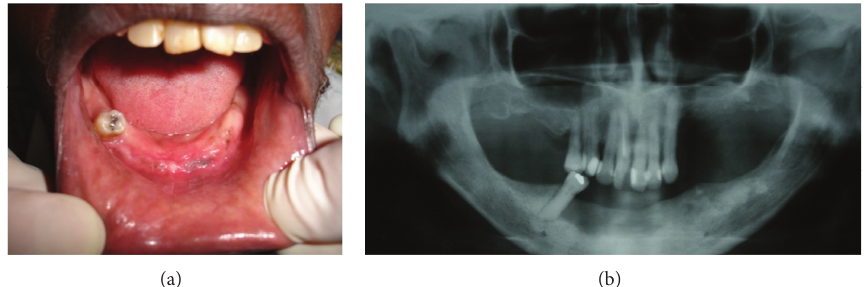
Figure 3: ((a) and (b)) Clinical and radiographic aspects 30 days after surgery showing almost complete healing of the operated area.